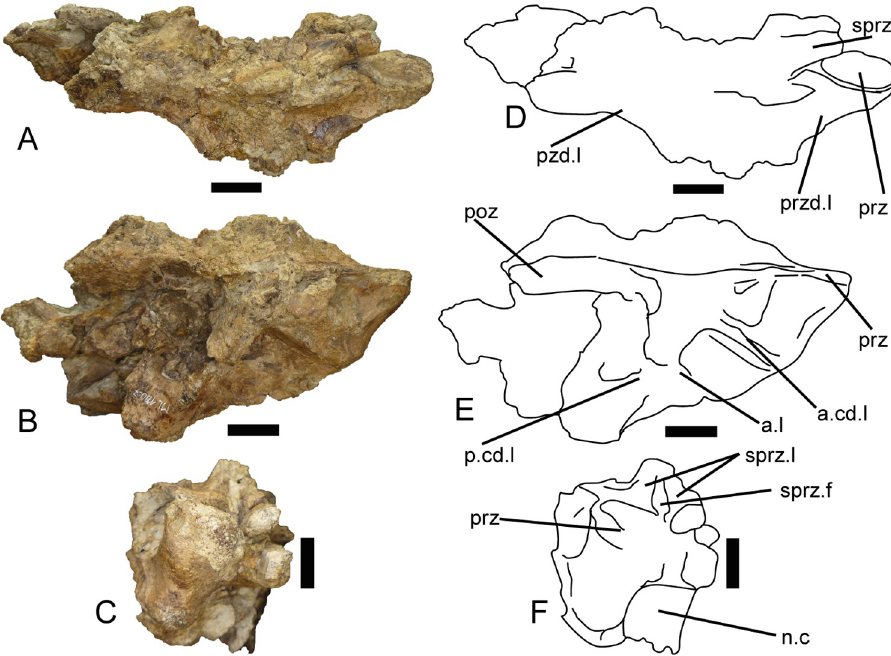
Fig 10. Partial dorsal neural arch of Iberospinus natarioi (ML1190-7). A, D ; dorsal, B, E ; lateral, and C, F ; anterior view. Scale bar is 25 millimeters. a.cd.l , anterior centrodiapophyseal laminae, a.l , accessory lamina, n.c , neural canal, poz , postzygapophysis, prz , prezygapophysis, przd.l , prezygadiapophyseal lamina, pzd.l , postzygapodiapophyseal lamina, p.cd.l , posterior centrodiapophyseal laminae, sprz.f , spinoprezygapophyseal fossa, sprz.l , spinoprezygapophyseal